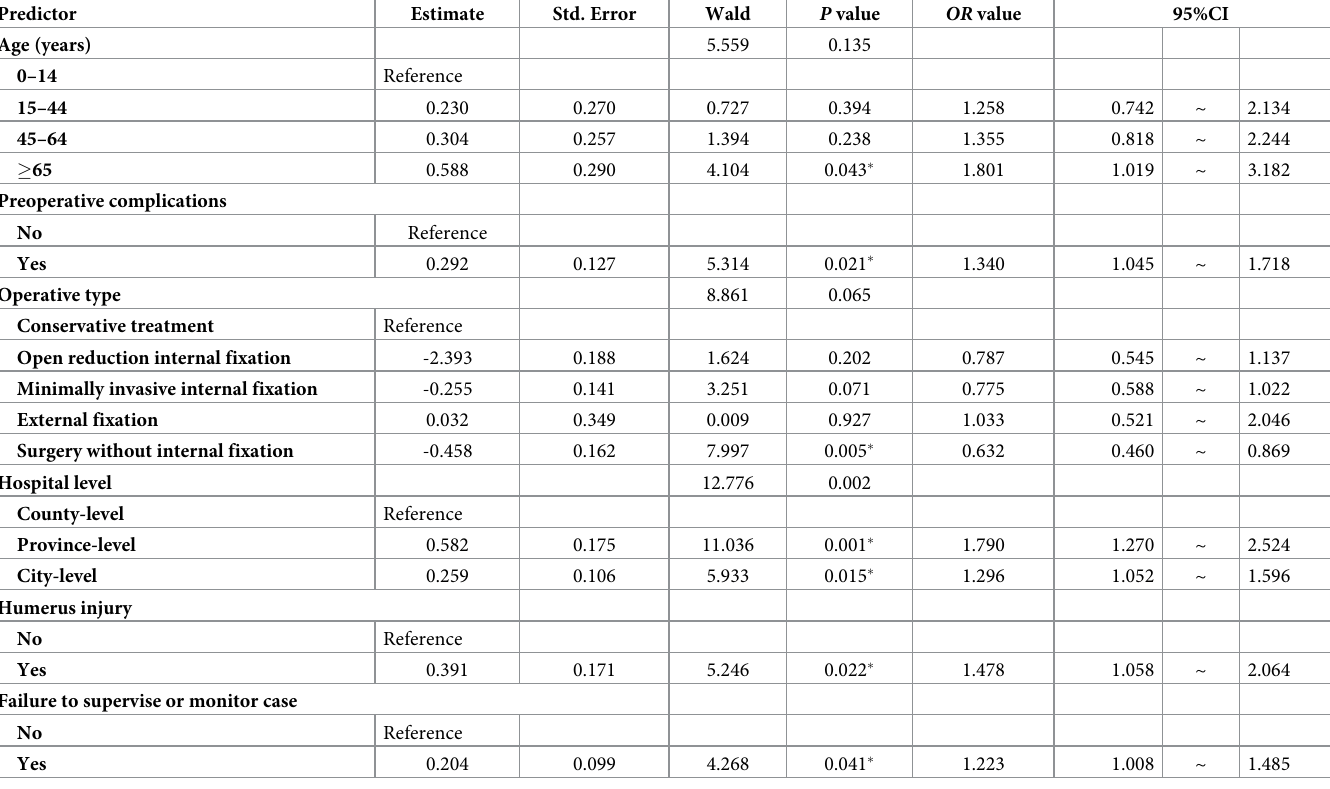
Table 5. Multivariate analysis of the factors associated with orthopedist’s degree of responsibility for medical malpractice in China between 2016 and 2017.